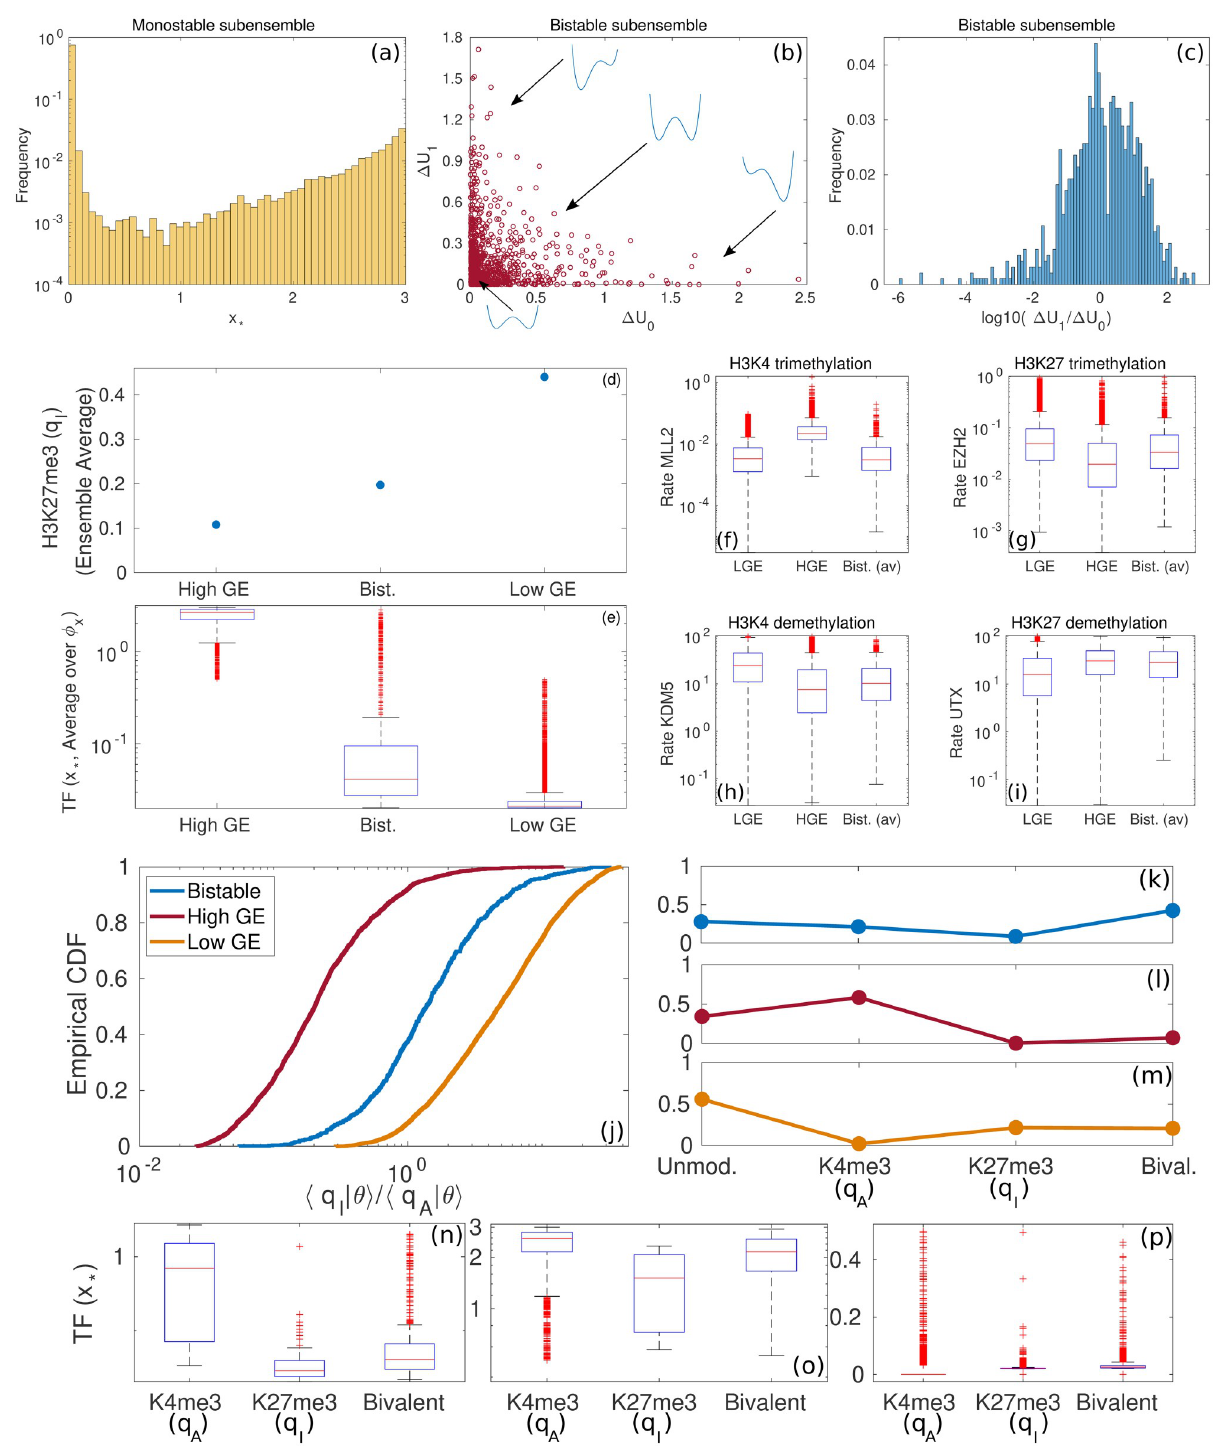
Fig 4. Validation of the ensemble model. Plots (a), (b), and (c) show summary statistics regarding the monostable and Bistable sub-ensembles. Plot (a) shows the distribution of modes, x � , within the monostable sub-ensemble. Plot (b) shows the scatter plot of the effective potential barriers, D U D U , within the Bistable sub-ensemble. Plot (c) shows the histogram of the ratio D U 1 data regarding statistics of the Bistable, High GE, and Low GE sub-ensembles. Plot (d) displays sub-ensemble averages of the H3K27me3 marks and (e) shows the boxplots of the TF levels (specifically, we use the modal TF concentration, x � as a proxy) for each of the sub-ensembles. These data are to be compared with the experimental results from [21]. Plots (f)-(i) show the boxplots of the distributions of activity of the chromatin modifiers for each of